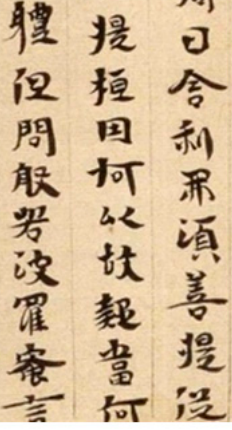
Figure 5. Great Treatise on the Perfection of